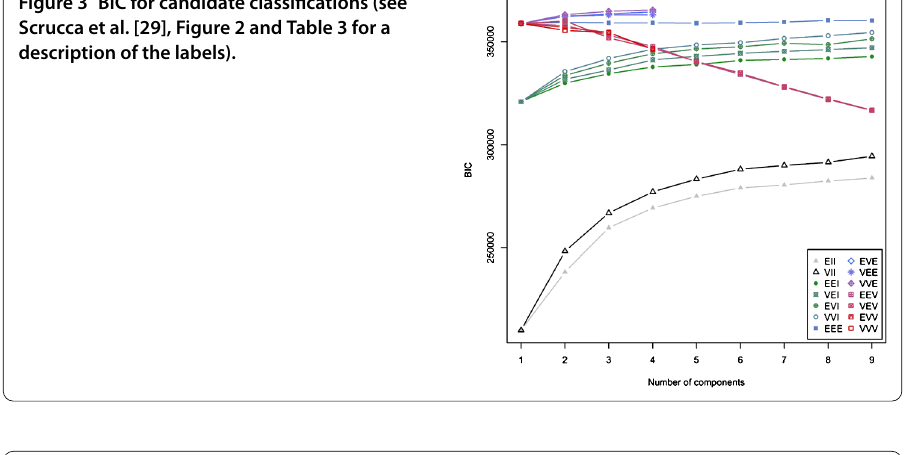
Figure 4 Certainty of allocation of WPC to most probable